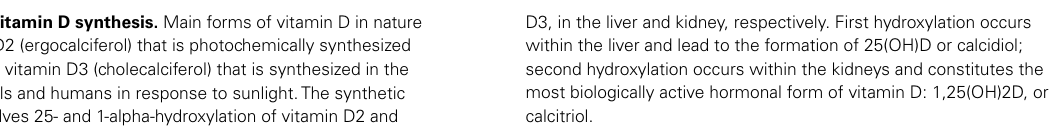
D3, in the liver and kidney, respectively. First hydroxylation occurs within the liver and lead to the formation of 25(OH)D or calcidiol; second hydroxylation occurs within the kidneys and constitutes the most biologically active hormonal form of vitamin D: 1,25(OH)2D, or